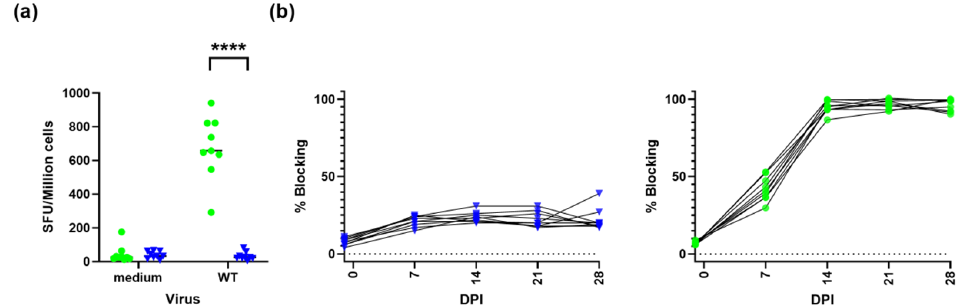
Figure 2. Immune responses after immunisation with ASFV-Kenya-IX-1033- ∆ CD2v. ( a ) IFN- γ ELISPOT using PBMC isolated from animals at day 21 after immunisation with ASFV-Kenya-IX-1033- ∆ CD2 (green) or PBS (blue) and stimulation with either medium or ASFV-Kenya-IX-1033 wildtype at MOI of 0.1 (WT). Statistical analysis was carried out using multiple t-test. Asterisks indicate the statistical difference between experimental groups (**** p < 0.0001). ( b ) Percentage blocking in competitive p72 antibody ELISA in animals after mock immunisation with PBS (blue) or ASFV-Kenya-IX-1033- Δ CD2 (green).